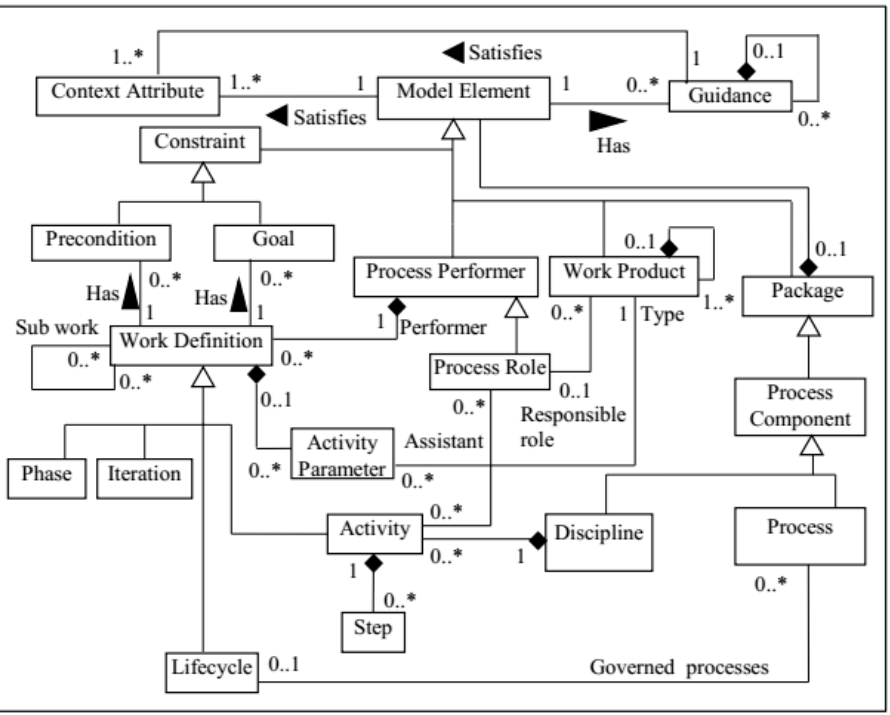
Figure 6. Metamodel of